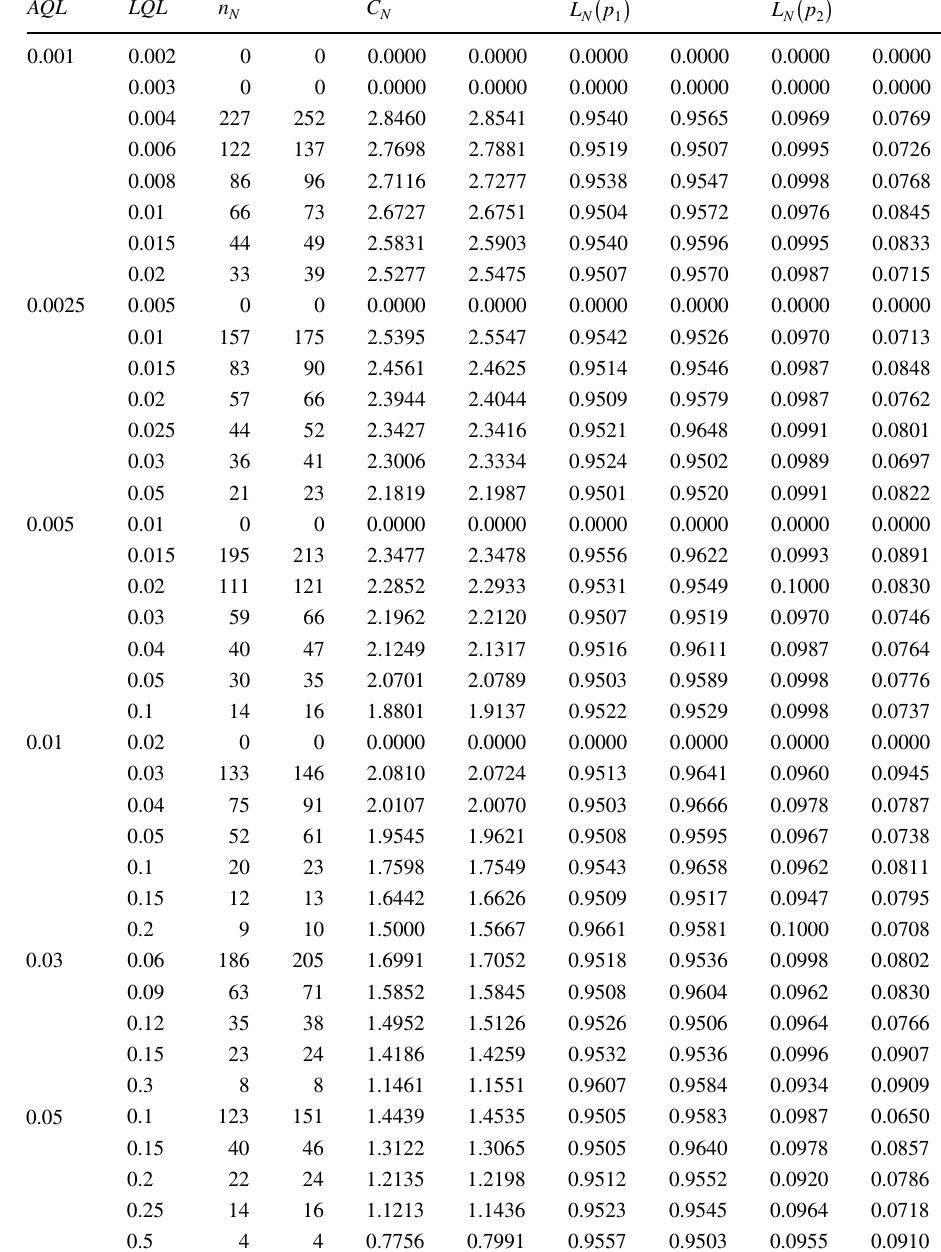
Table 7 Plan parameters for the proposed plan, when 𝜎 Y N is = unknown and 𝜌 X N Y N